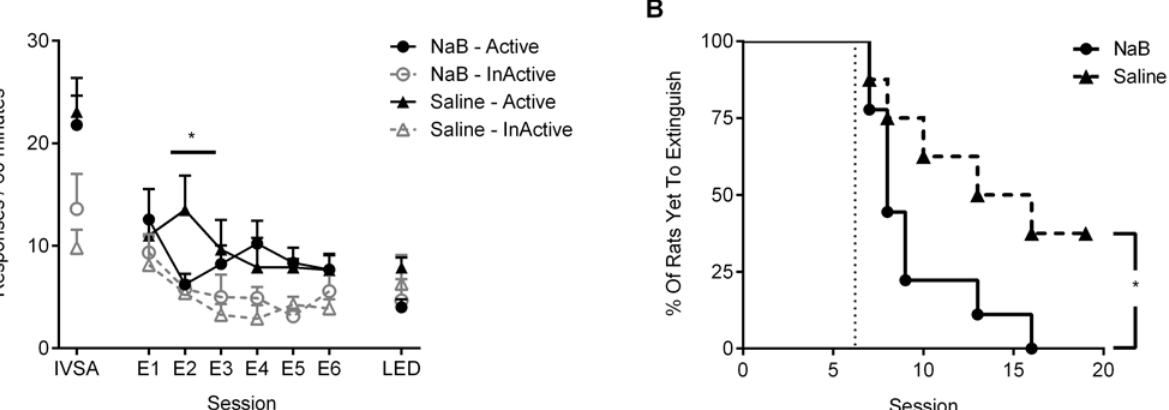
Fig 3. Experiment 2: HDAC inhibition facilitates cue-extinction of nicotine self-administration. (A) Active and inactive responses during acquisition of intravenous nicotine self-administration (IVSA; average of the last 3 sessions) and the first six days (E1 – E6) and last day (LED) of extinction for rats treated with sodium butyrate (NaB; n = 9) and saline (n = 8) immediately after each extinction session; (B) Survival curve showing the percentage of rats in each group yet to meet the extinction criteria (active responses < 30% of last three days of acquisition). Dotted vertical line indicates the minimum number of extinction